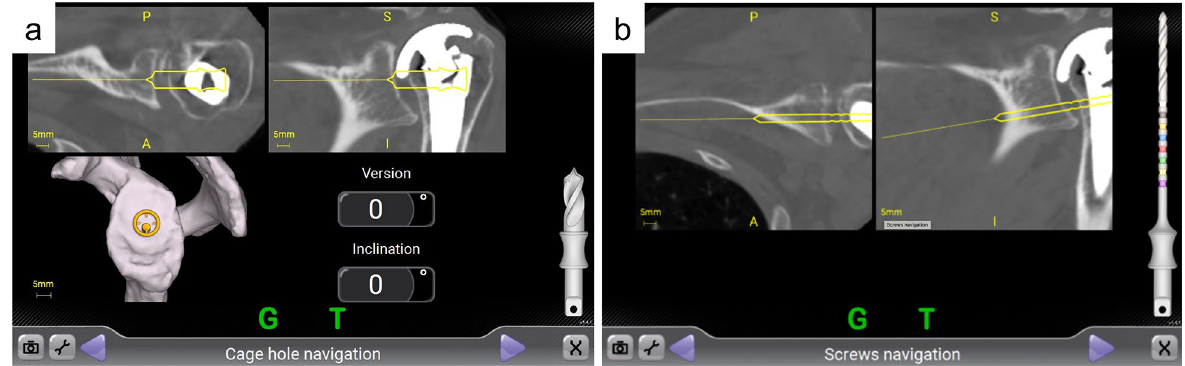
Figure 2. The Exactech GPS navigation screen. ( a ) The central peg hole shows 0° of anteversion error and 0° of superior inclination error in comparison with the pre-operative plan. ( b ) The drill bit direction is confirmed for inferior screw insertion with real-time monitoring. P posterior, A anterior, S superior, I